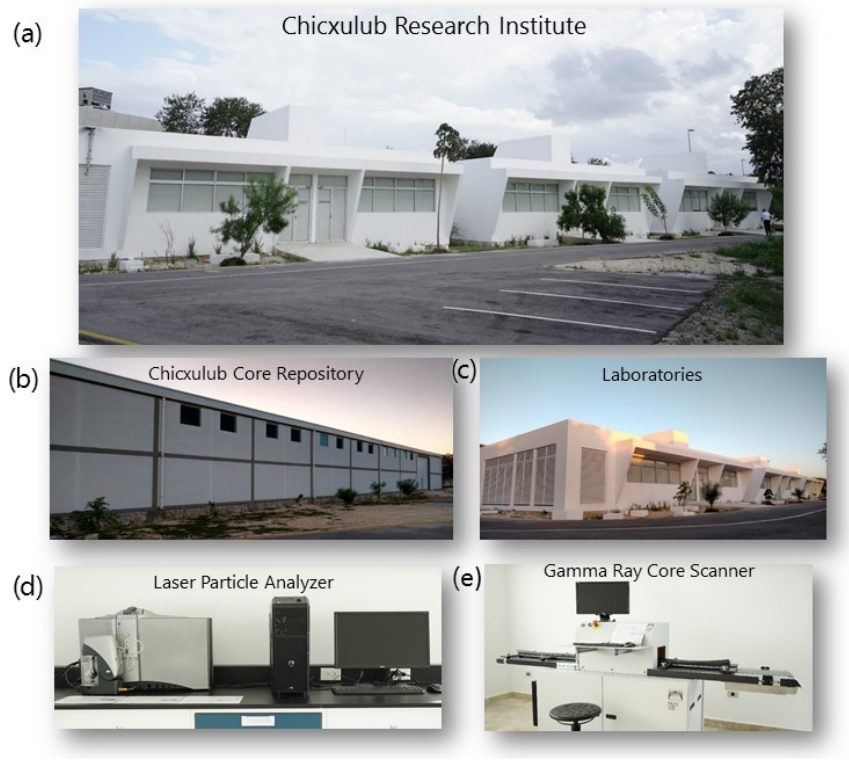
Figure 7. Chicxulub laboratories, with views of the six laboratory facilities and some of the instrumental facilities.